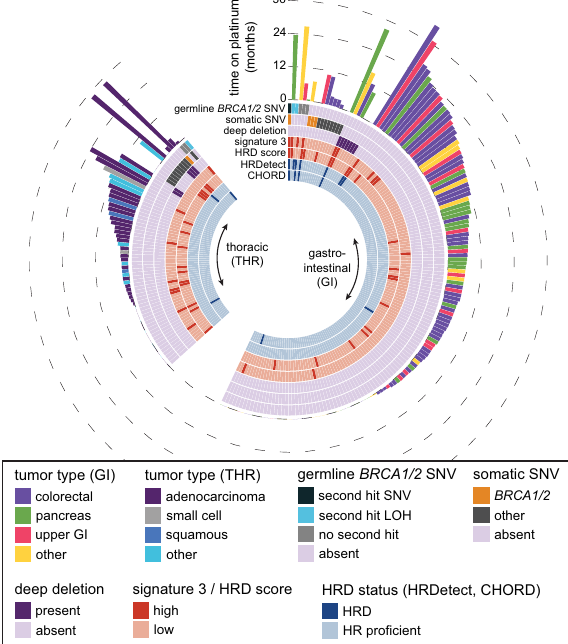
Fig. 1 Patient summary. Overview of 223 patients with metastatic gastrointestinal and thoracic malignancies who underwent WGS and